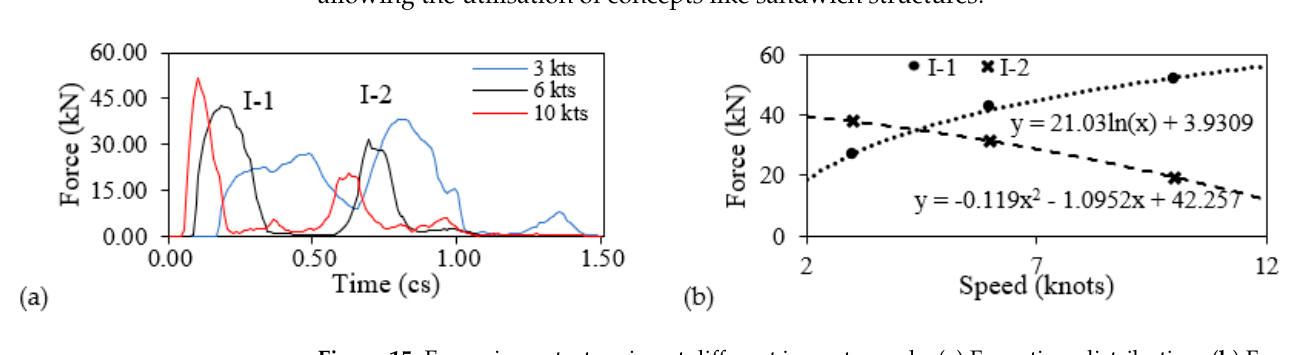
Figure 15. Forces in contact region at different impact speeds. ( a ) Force time distribution. ( b ) Force speed distribution.